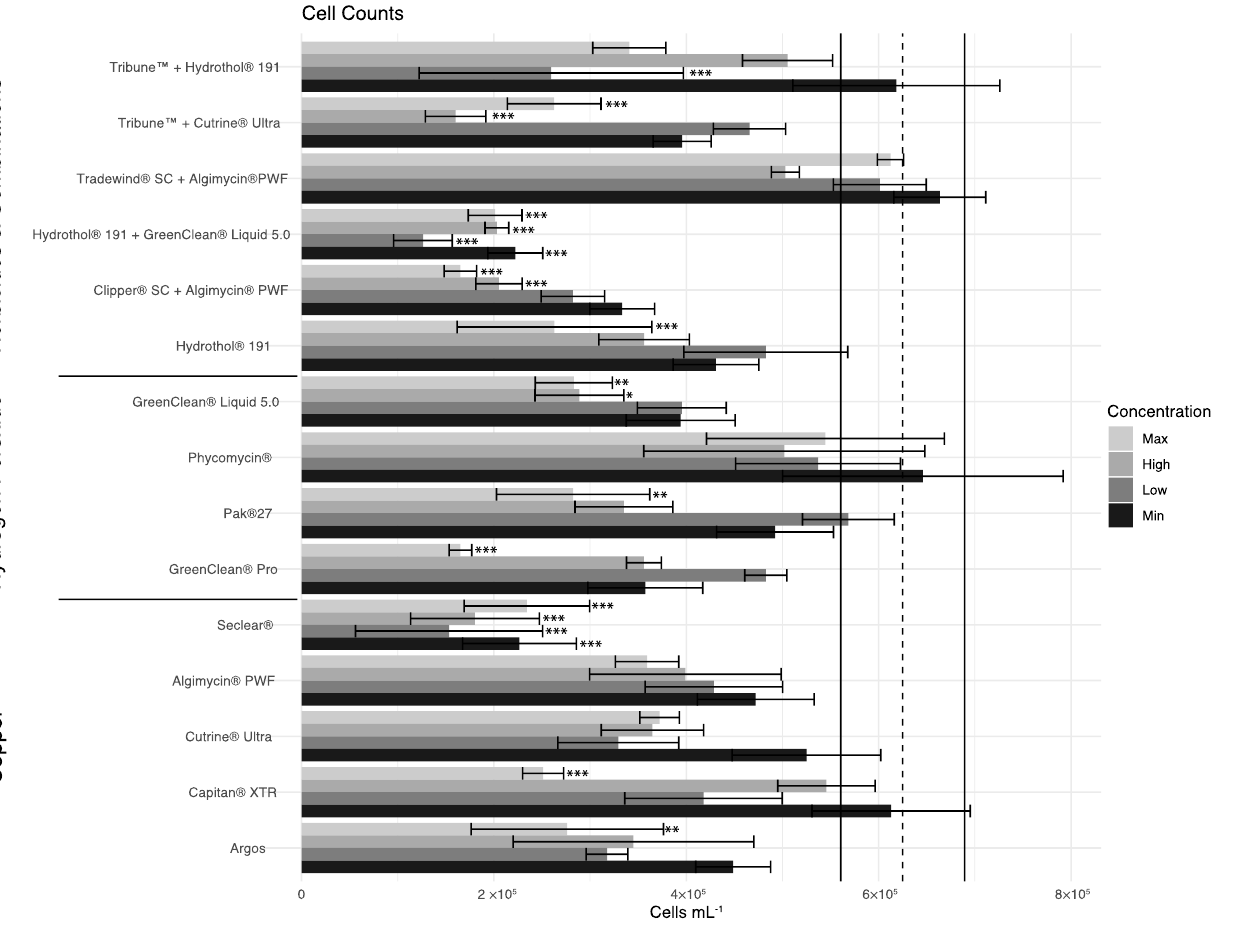
Figure 2. Cell counts of Microcystis spp. at 72 h. Error bars represent standard error. Dotted vertical line represents control mean with solid bars representing standard error. Asterisks represent significance where * = p < 0.05, ** = p <0.01, *** = p < 0.001.